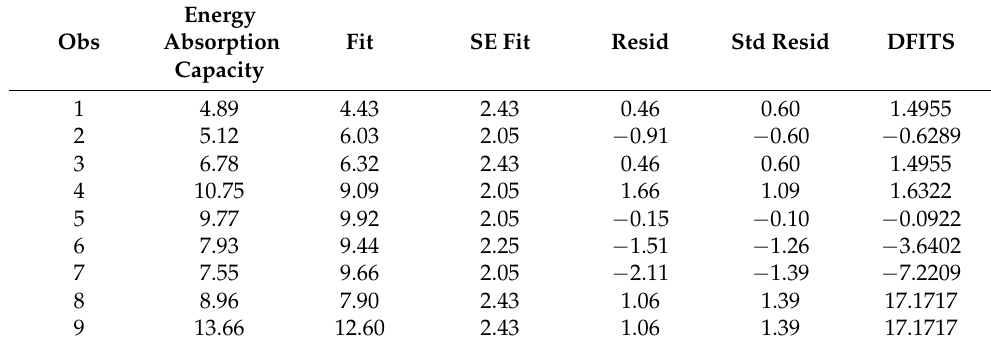
Table 8. Fits and diagnostics for all observations for energy absorption capacity.